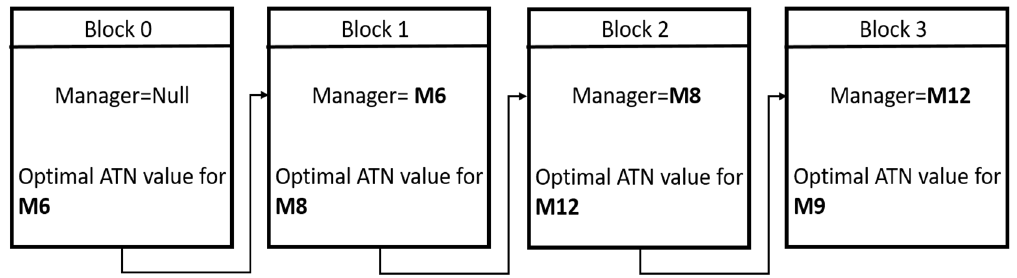
Figure 4. Manager selection process using PSO.